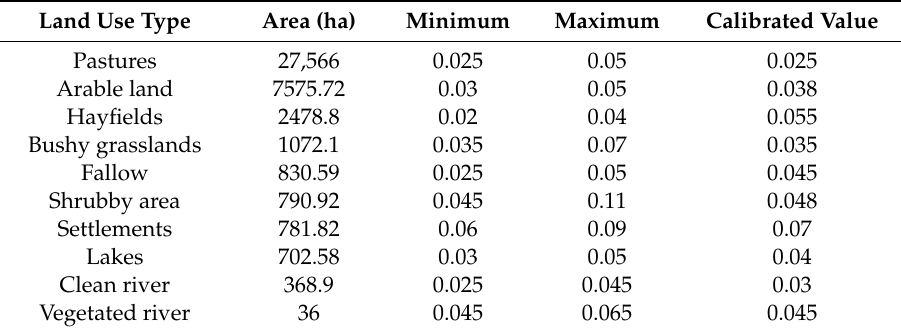
Table 4. Calibrated land use types and their parameter